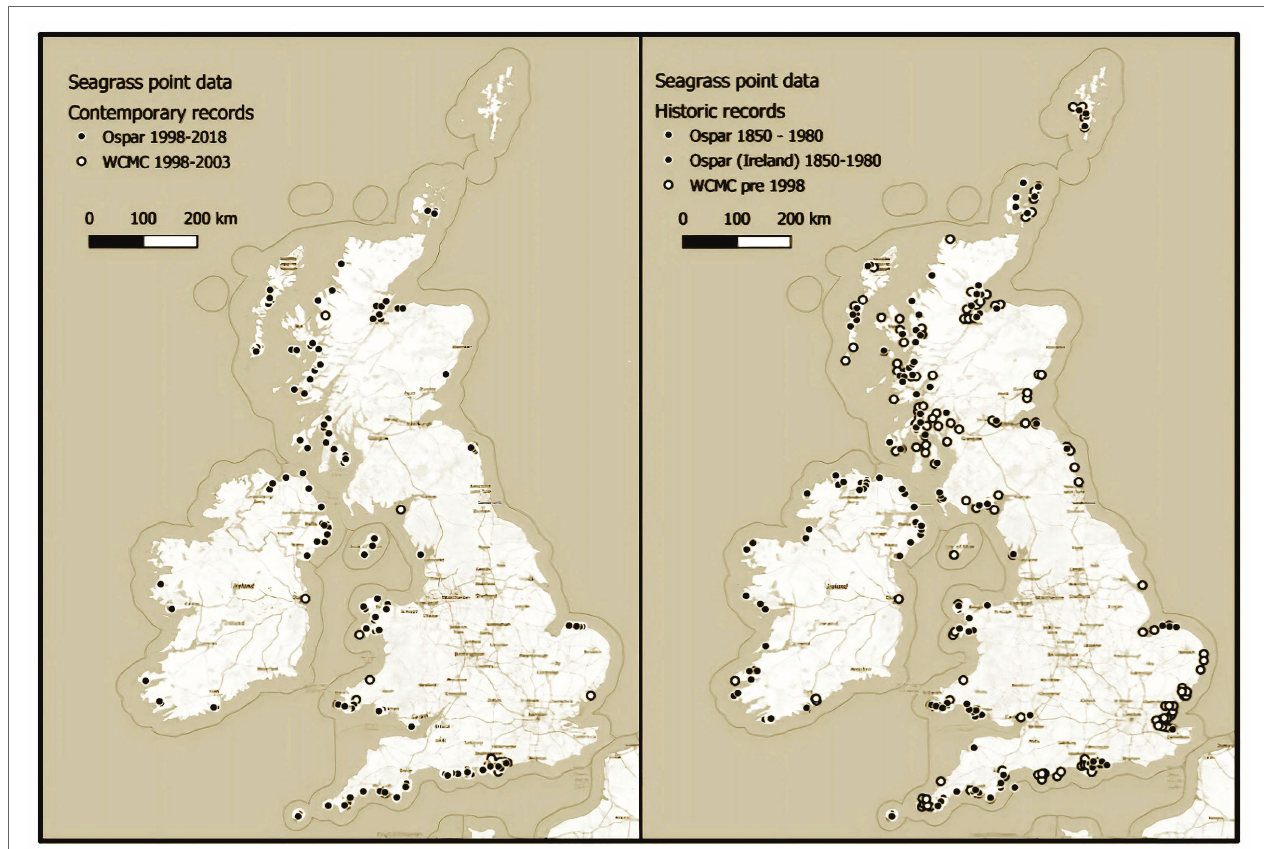
FIGURE 5 | Seagrass point data from the OSPAR and UNEP-World Conservation Monitoring Centre datasets showing pre-1998 surveys (left) and post-1998 surveys (right).